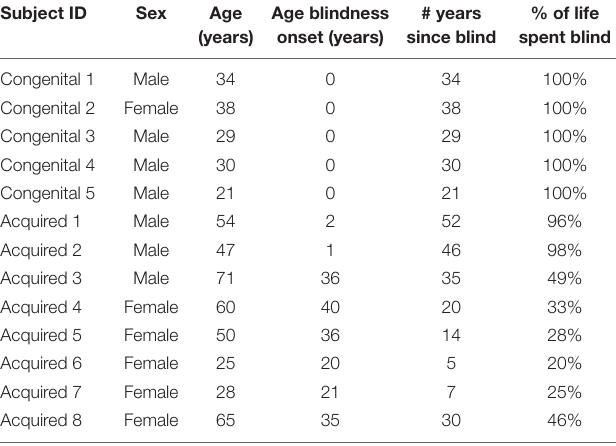
TABLE 1 | Demographics and blindness information for all anophthalmic